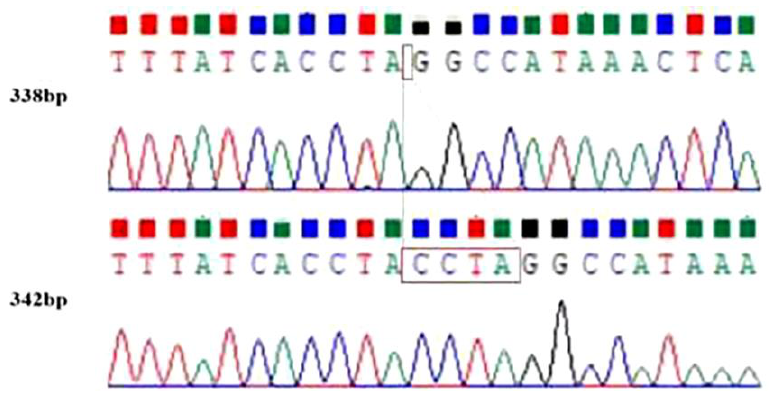
Figure 3. The LRRC8B gene InDel site via sequencing. Note: the red line and box show the location of the base mutation.